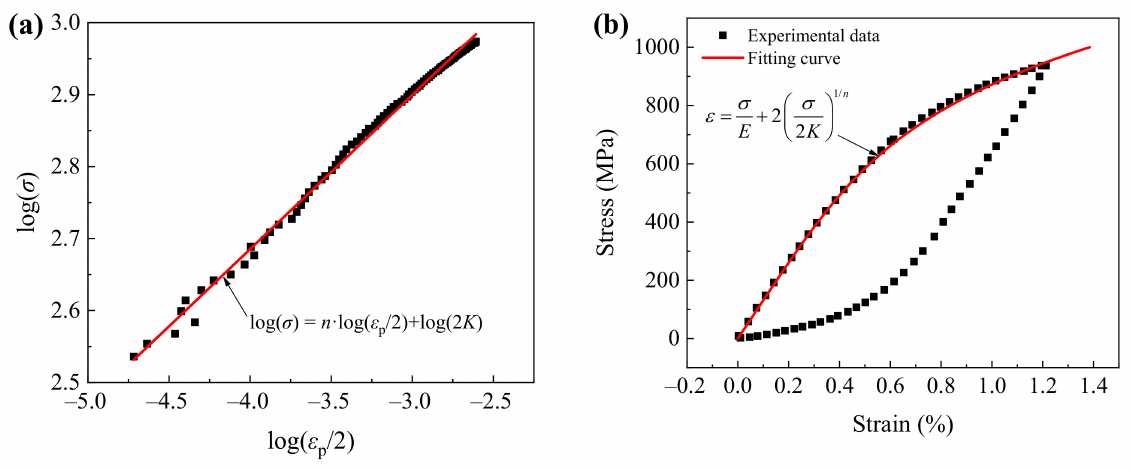
Figure 15. Identification method of K and n : ( a ) plot of log( σ ) vs. log( ε p /2), and ( b ) fitting result of the tensile part of the half-life hysteresis loop under the strain amplitude of 0.6% at 700 ◦